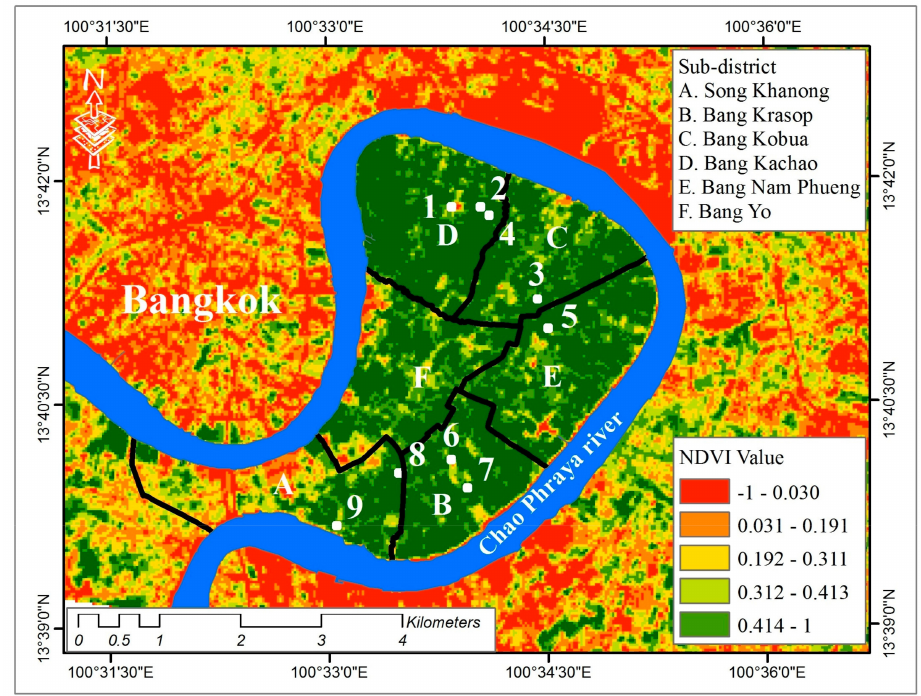
Figure 2. NDVI classification image of Bangkok and the Chao Phraya River showing location of the Bang Kachao Green Space (BKGS). Boundaries of the 6 sub-districts are shown. Numbers are the locations of the nine research